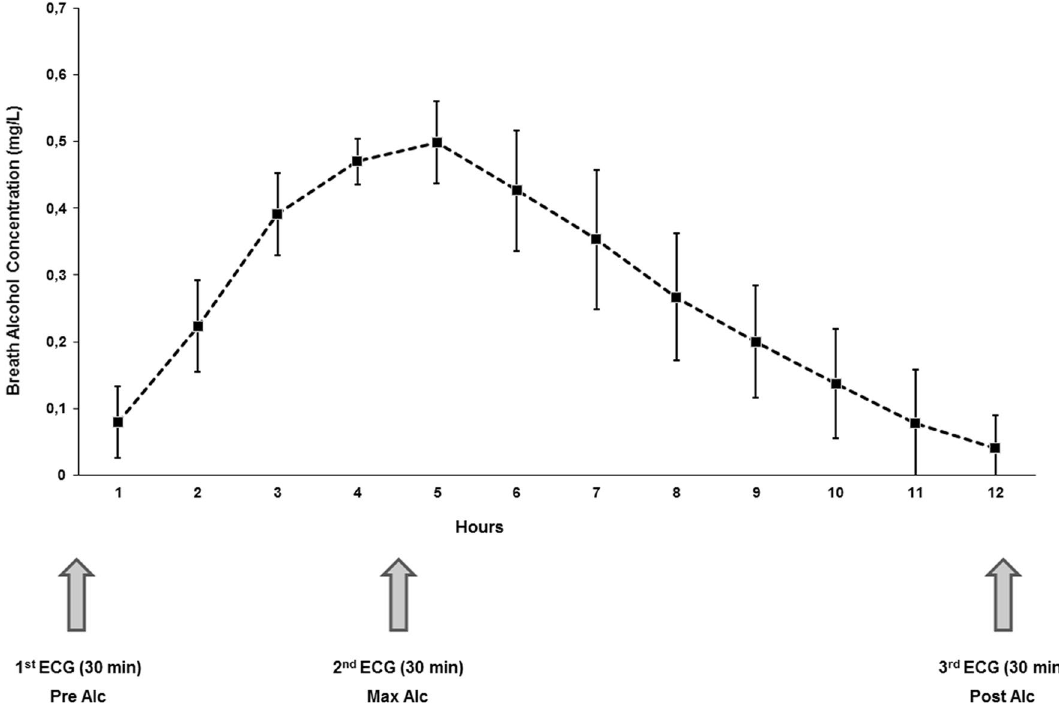
Figure 1. Study design and mean breath alcohol concentration during the trial. 30-min-ECGs were recorded before starting the alcohol infusion, at the time of maximum breath alcohol concentration, and after alcohol concentration dropped to approximately 0.05 mg/l. N = 15 for all experiments and